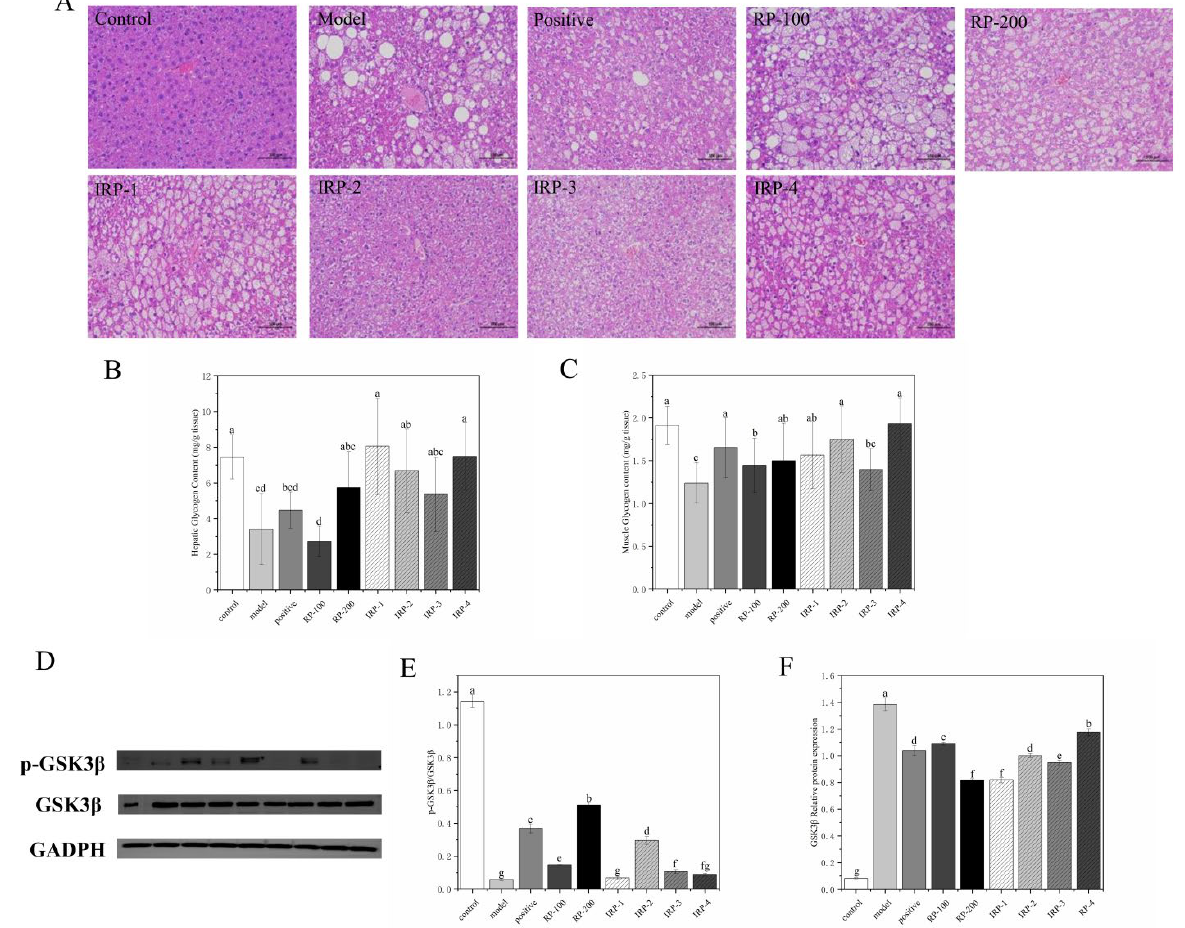
Figure 3. Effects of RP and IRP 1–4 on Micromorphology of Liver, hepatic glycogen content, muscle glycogen content, and GSK3 β protein expression in db/db mice. ( A ) H&E staining of the liver ( × 200 magnification), ( B ) hepatic glycogen content, ( C ) muscle glycogen content. ( D ) Representative Western blots depict p-GSK3 β , GSK3 β , and GADPH. ( E ) RP and IRP 1–4 decreased the GSK3 β protein level. ( F ) RP and IRP 1–4 increased p-GSK3 β /GSK3 β . All data were expressed as mean ± SD ( n = 6). Different letters indicate a significant difference ( p < 0.05).